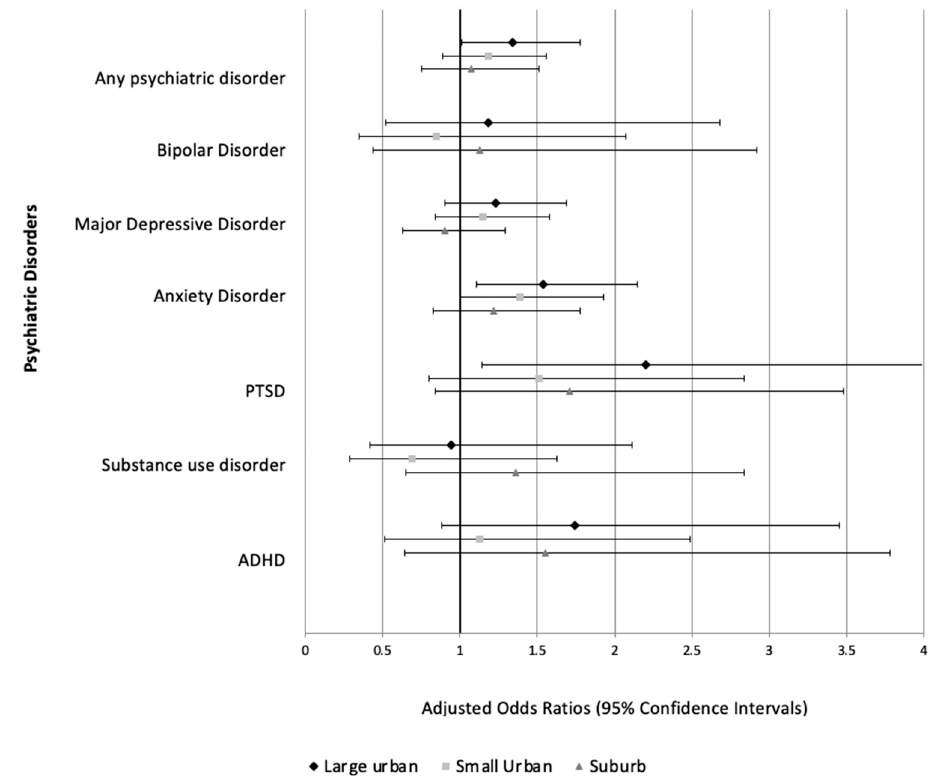
Figure 1. Multivariable logistic regression models showing associations between environment of birthplace and psychiatric disorders. (Reference group = Rural).